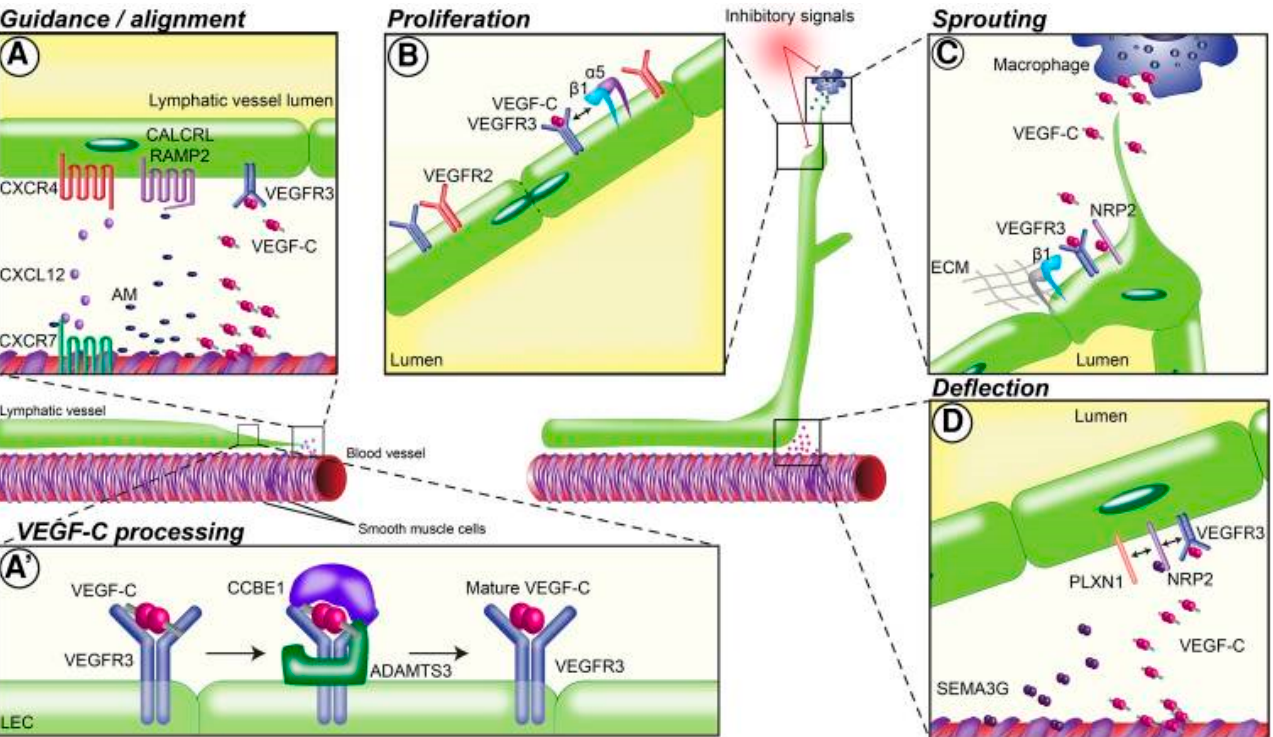
Figure 1. Guidance mechanisms for lymphatic network patterning in different stages of lymphatic vessel development. ( A ) Preexisting lymphatic vessels align with nearby blood vessels by reacting to guidance molecules released by arteries and smooth muscle cells. Guidance at this stage is mediated by the molecules VEGF-C and CXCL12 and the receptors VEGFR-3, CXCR4, CXCR7, CALCRL, and RAMP2. ( A’ ) Vascular endothelial growth factor (VEGF)-C binds to surface proteins on the lymphatic endothelial cell (LEC) matrix and is processed into mature VEGF-C. VEGF-C processing is primarily mediated by CCBE1 and ADAMTS13. ( B ) VEGF-C binding to VEGF receptor (VEGFR)-2/3 and interaction with integrins induces LEC proliferation; α 5 and β 1 integrins also play a role at this step. ( C ) Macrophages release additional guidance molecules that initiate lymphatic vessel sprouting and branching. VEGF-C binding to its receptor VEGFR-3 and the coreceptor NRP2 drives this step, along with β 1 integrins. ( D ) Deflection of lymphatic vessels during network formation occurs via release of repulsive guidance cues such as SEMA3G from nearby blood vessels. VEGFR-3, NRP2, and PLXN1 form a receptor complex that binds VEGF-C [18]. Reproduced with